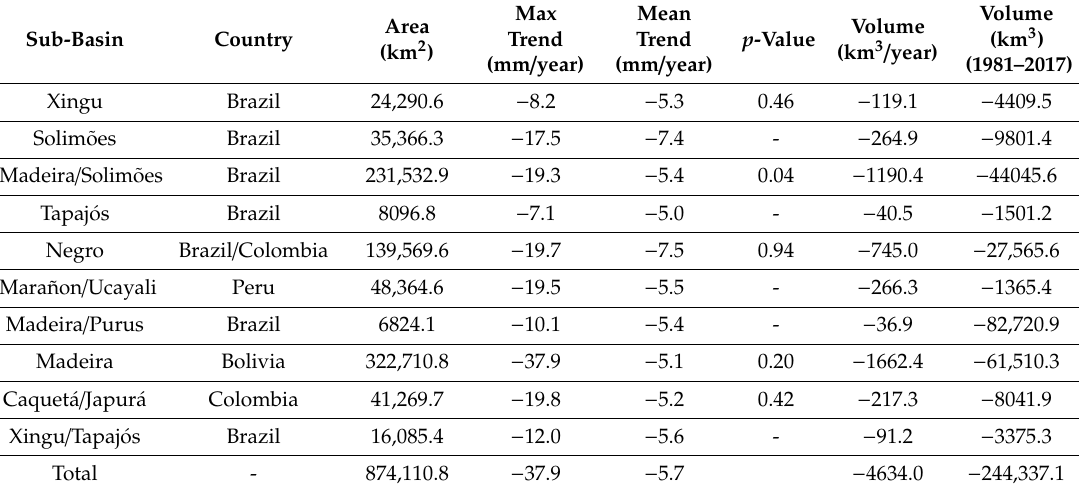
Table 2. Clusters with negative trends.